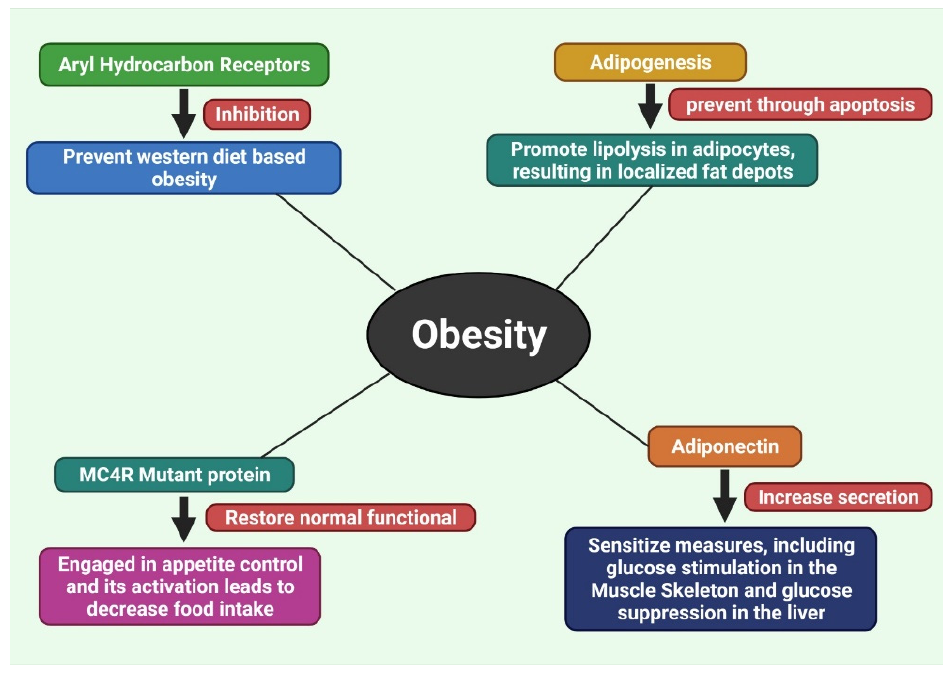
Figure 6. Different ways of treating obesity.